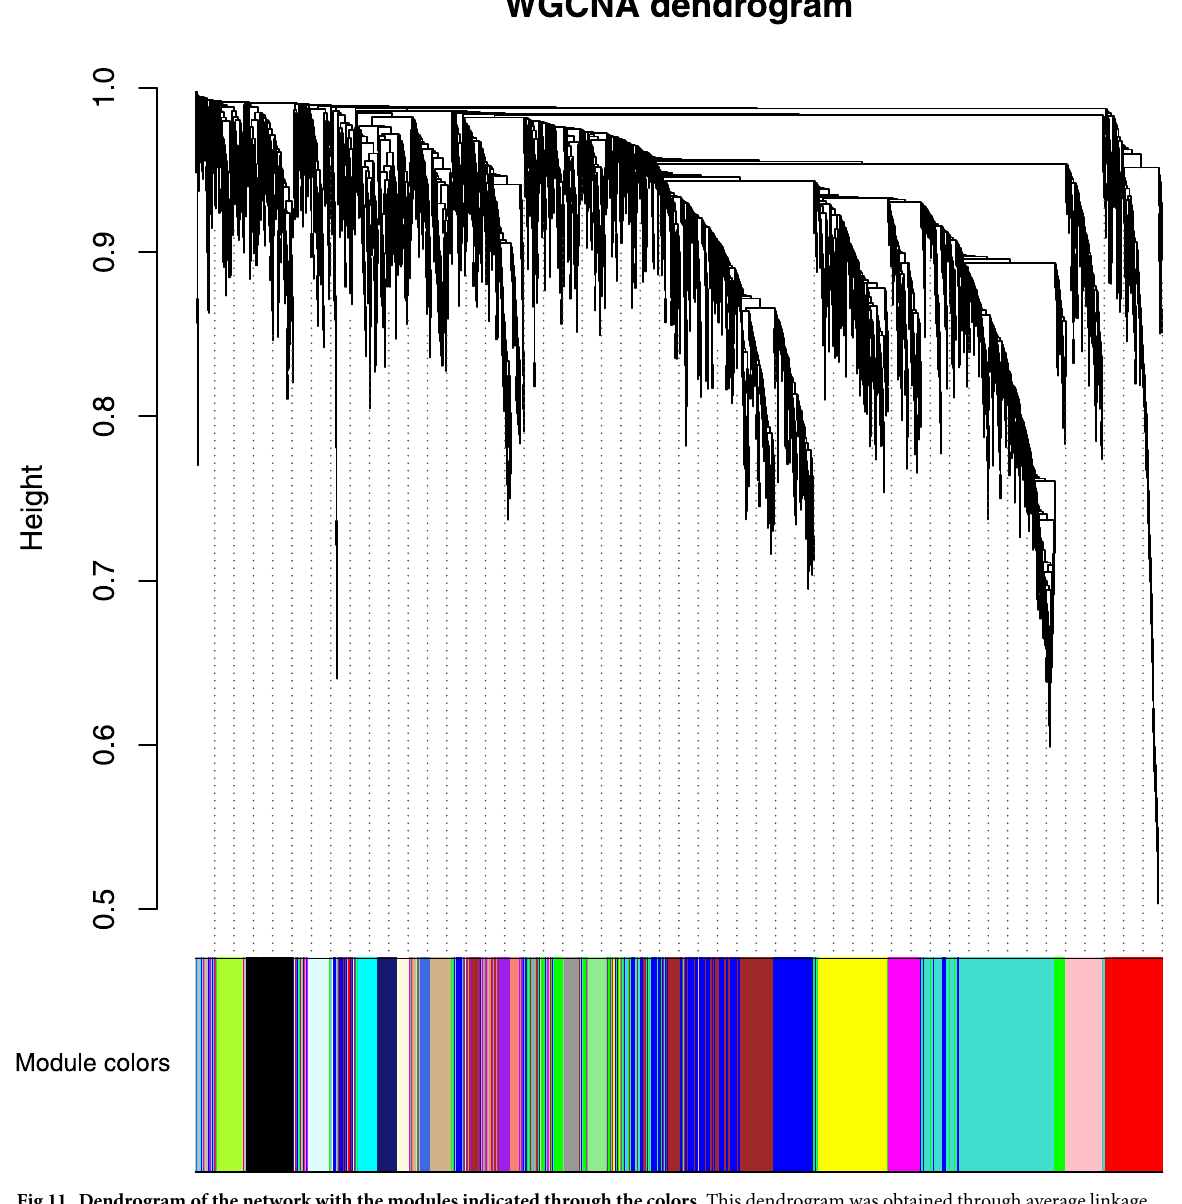
Fig 11. Dendrogram of the network with the modules indicated through the colors. This dendrogram was obtained through average linkage hierarchical clustering. The color spectrum underneath the plot indicates the module assignment determined by means of the Dynamic Tree Cut.